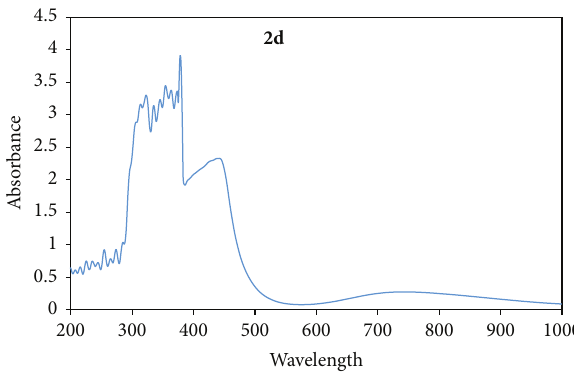
Figure 8: Electronic spectrum of Cu(Bmpp-Sn) 2 (H 2 O) 2 ( 2d ).